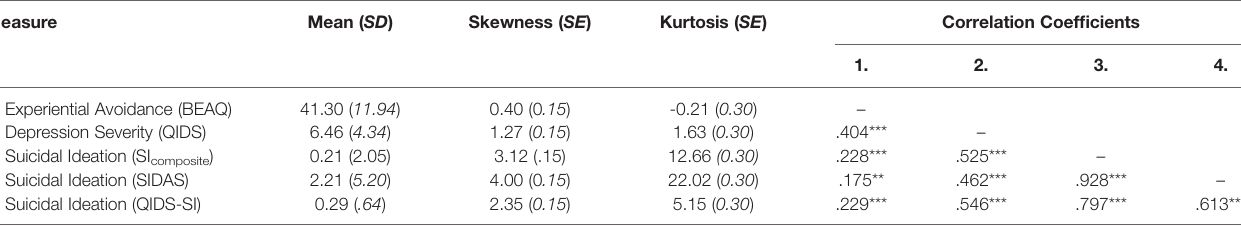
TABLE 3 | Study 2: Means, standard deviations, and correlation coef fi cients for baseline measures. Measure Mean ( SD ) Skewness ( SE